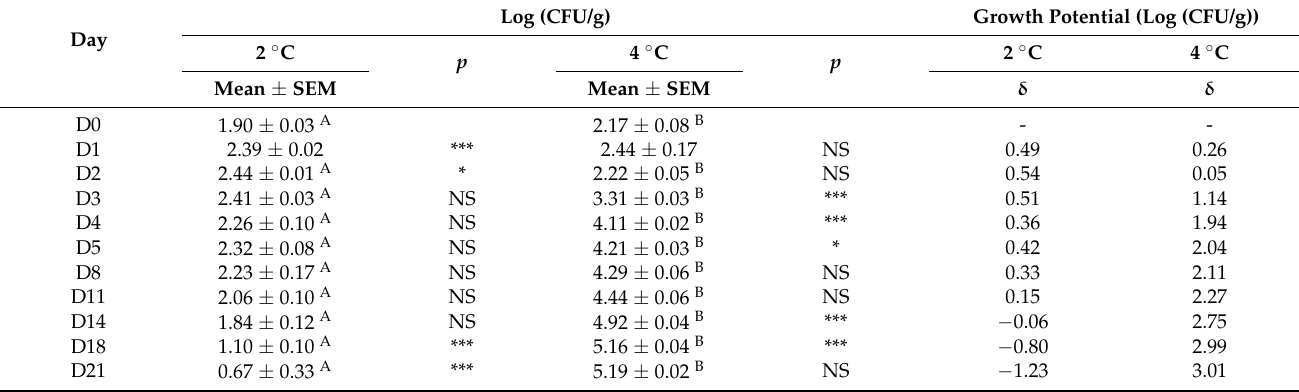
Table 8. Effect of post dry aging on Listeria growth in inoculated samples of buffalo S+/F meat stored at 2 ◦ and 4 ◦ C. Listeria concentration (Log (CFU/g)) is expressed as the mean ± SEM for each inoculated group and at each sampling time. Log Day